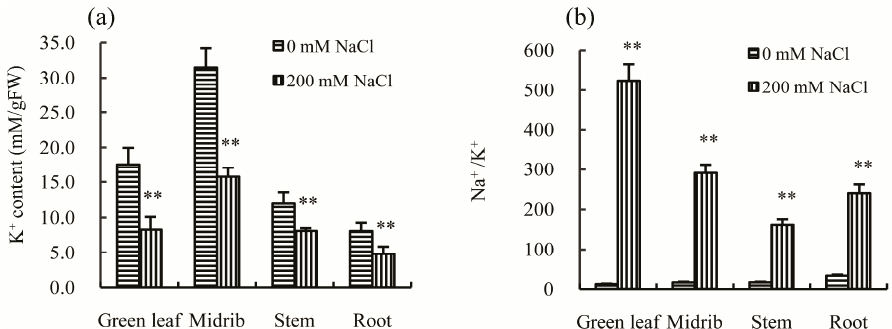
Figure 5. Effects of 200 mM NaCl stress on: the K + concentration ( a ); and the Na + /K + ratio ( b ), in the green leaves, midribs, stems, and roots of Chinese cabbage seedlings. All parameters were measured on Day 30 after salt treatment. The values are the means (±SD) of five replicates. ** Indicate p < 0.01.